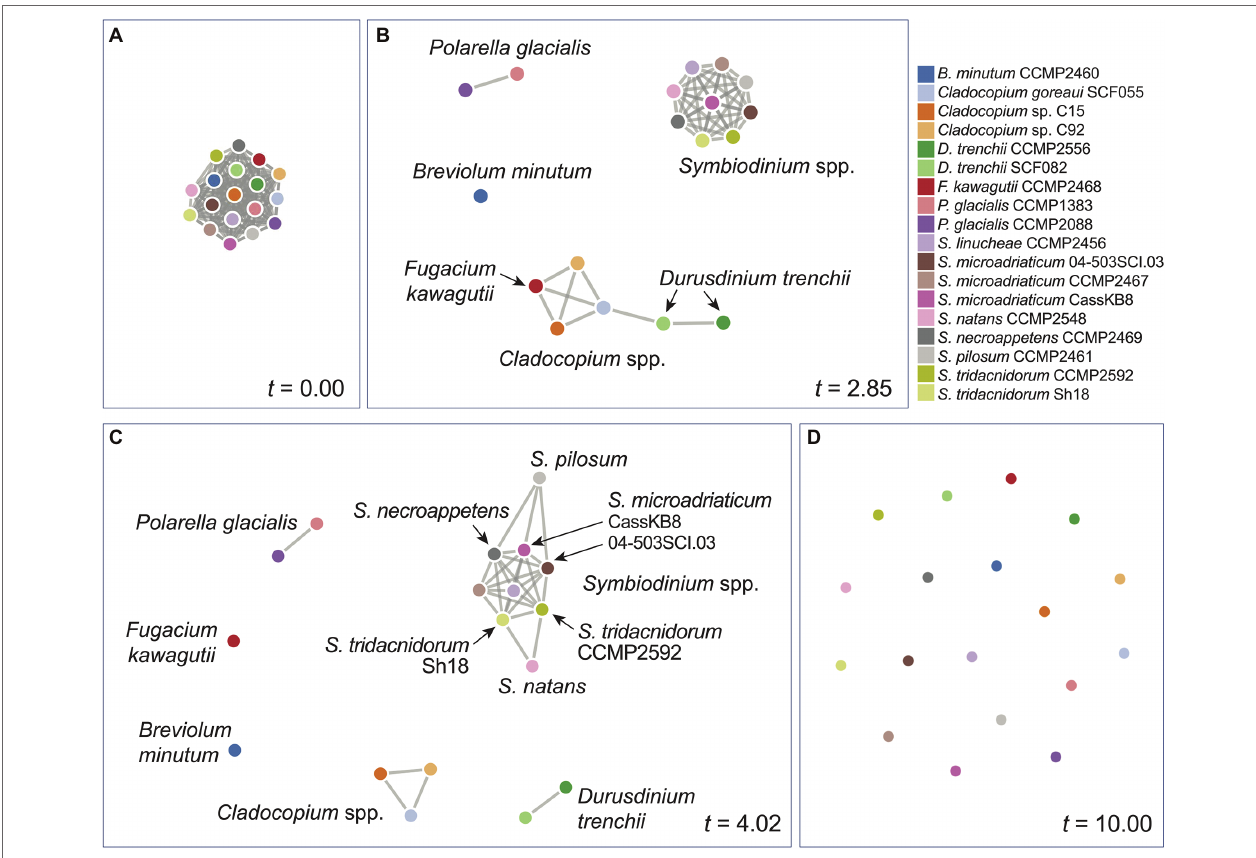
FIGURE 3 | Network of genome relatedness of 18 Suessiales inferred using the rmWGS data at different t -values: (A) t = 0.00, (B) t = 2.85, (C) t = 4.02, and (D) t = 10.0. The colour used to represent each genome is shown in the